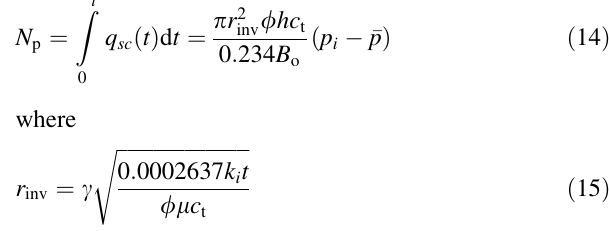
Fig. 3 Analytical solution procedure under constant bottomhole